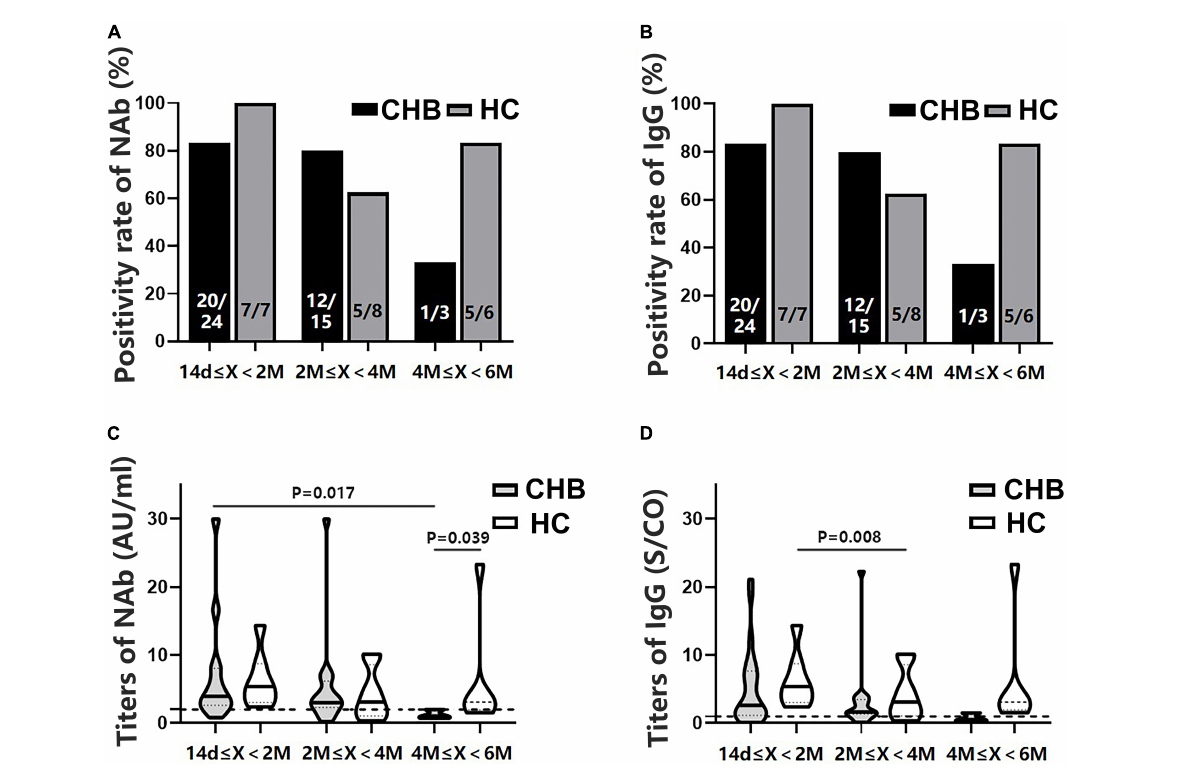
FIGURE4 Comparison of the positivity rates and titers of antibodies against severe acute respiratory syndrome coronavirus 2 (SARS-CoV-2) between patients with CHB and HCs at 14 days–2 months, 2–4 months, and 4–6 months after the second vaccine dose. (A,B) Comparison of NAb and immunoglobulin G (IgG) positivity rates between the two groups at different time intervals. (C,D) Comparison of NAb and IgG antibody titers between the two groups at different time intervals; n1/n2 in bars, positive cases/all cases; X, days after the second dose; dotted line, cutoff value; CHB, chronic hepatitis B; HCs, healthy controls; NAb, neutralizing